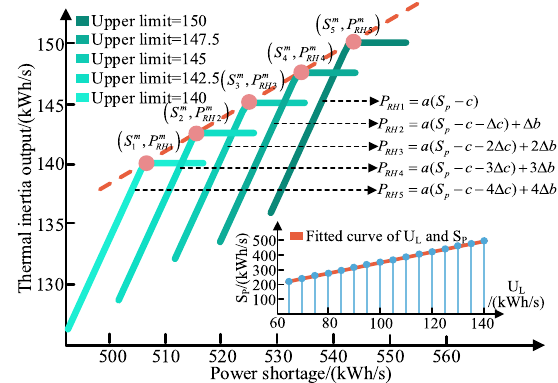
Fig. 14 The curve of S P -U L and relative illustration curves under different upper limits of thermal inertia